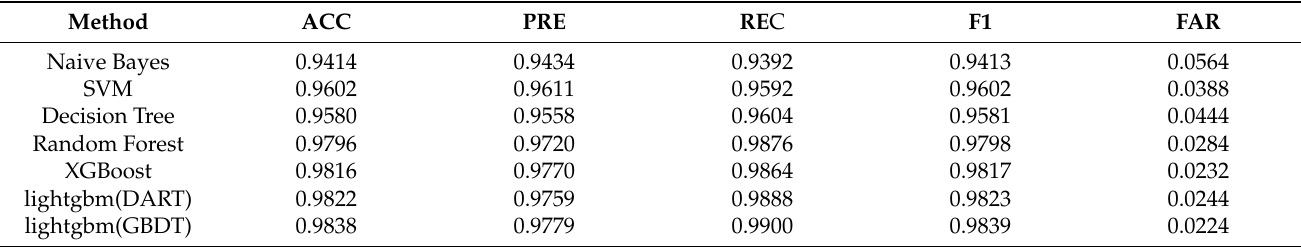
Table 7. Comparisons of different backend classifier algorithms.